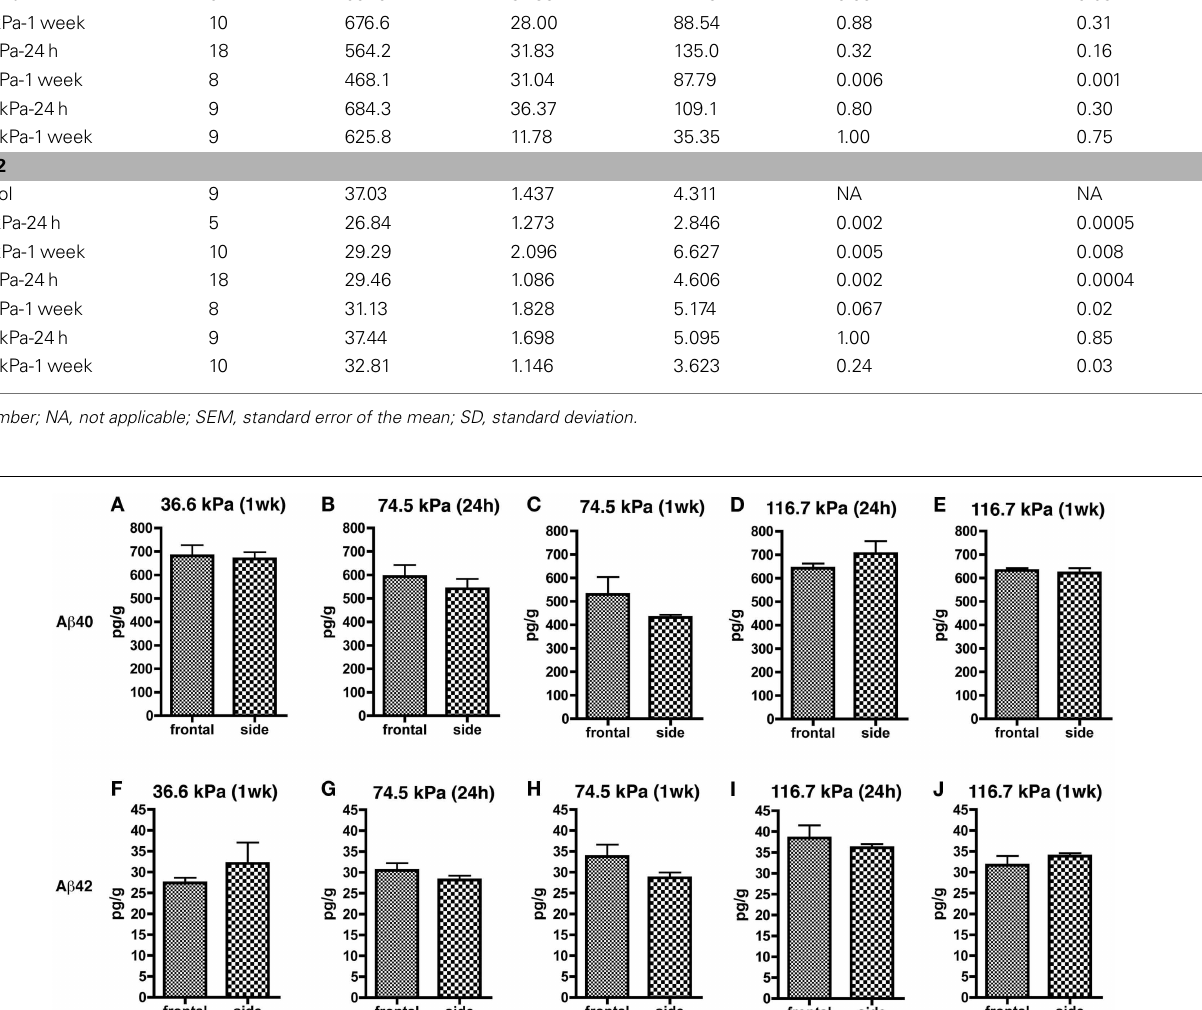
FIGURE 3 | Results ofA β 40 (A–E) and 42 (F–J) ELISAs onTriton X-100 brain extracts are presented for rats exposed to frontal or side blast exposures of 36.6 (A,F), 74.5 (B,C,G,H), or 116.7kPa (D,E,I,J) harvested at 24hours (24h) or 1week (1wk) post-blast exposure. Values are presented ± the SEM.There were no statistically significant differences between any of